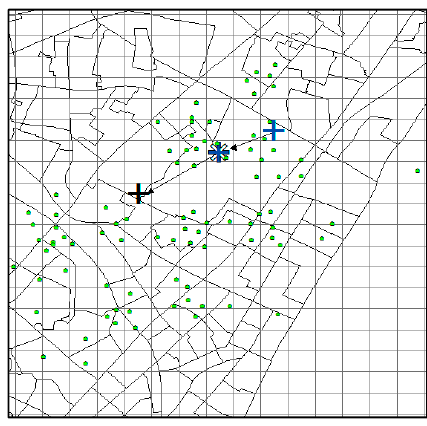
Figure 18. Result of ZMDB.